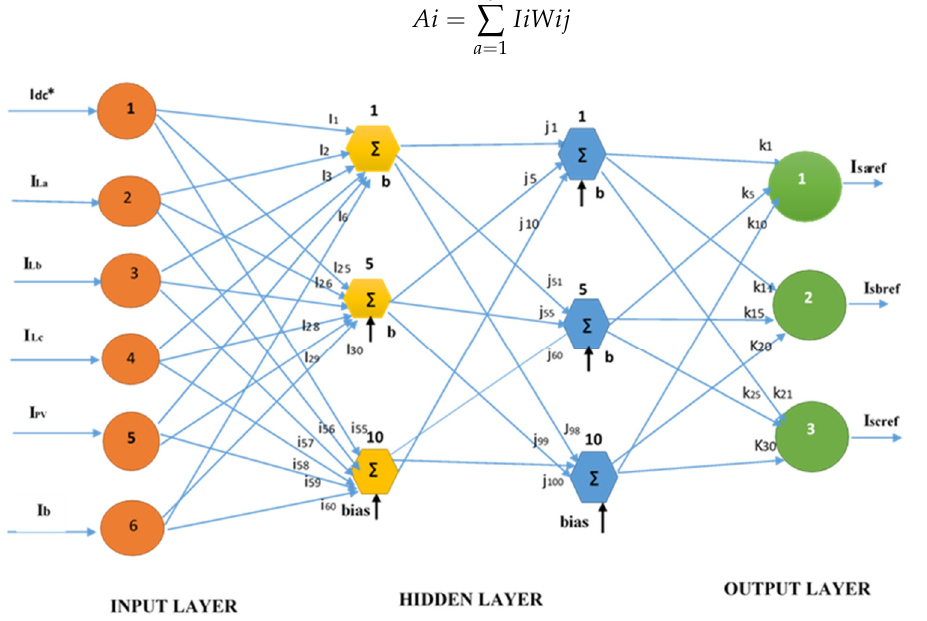
Figure 11. Shunt ANN model development.